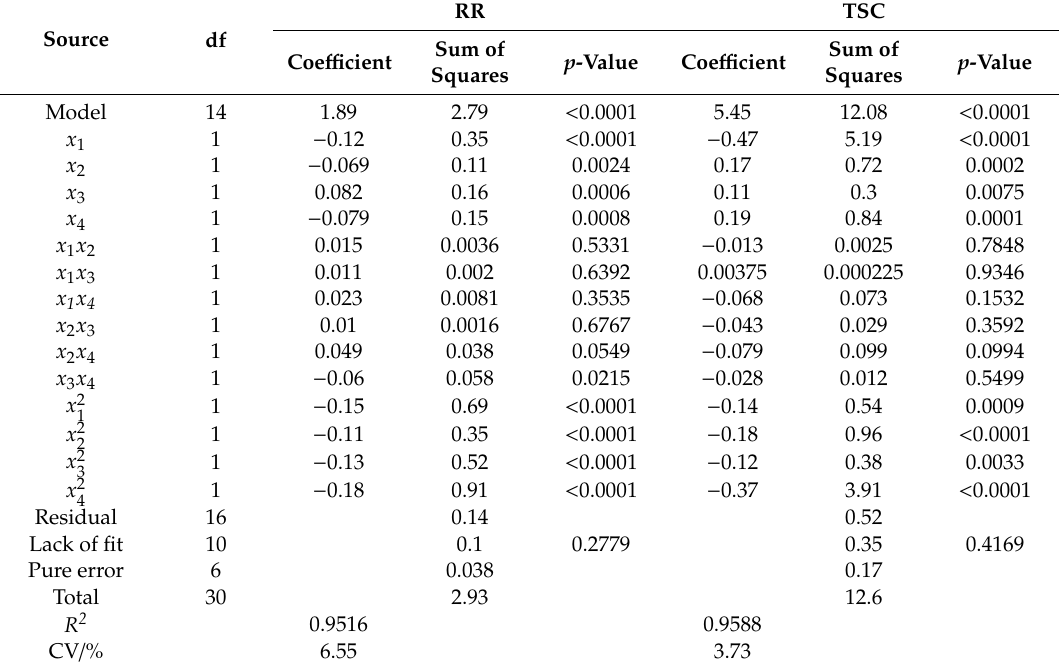
Table 4. ANOVA evaluation of linear, quadratic, and interaction terms for each response variable and coe ffi cient of prediction